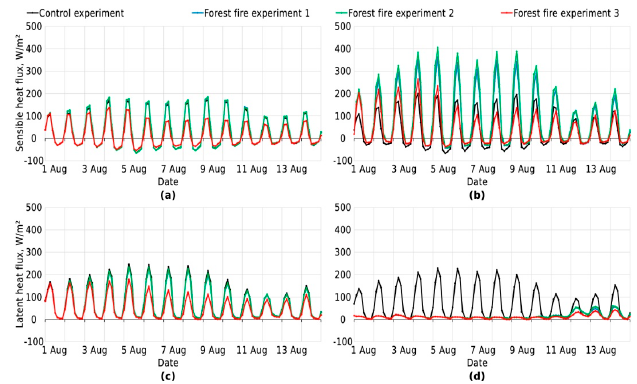
Figure 3. Temporal variability of energy fluxes for Area 1 from 1–14 August 2019 for various forest fire experiments: ( a ) sensible heat fluxes averaged over the entire area, W/m 2 ; ( b ) mean sensible heat fluxes at burned sites, W/m 2 ; ( c ) latent heat fluxes averaged over the entire area, W/m 2 ; ( d ) mean latent heat fluxes at burned sites, W/m 2 .